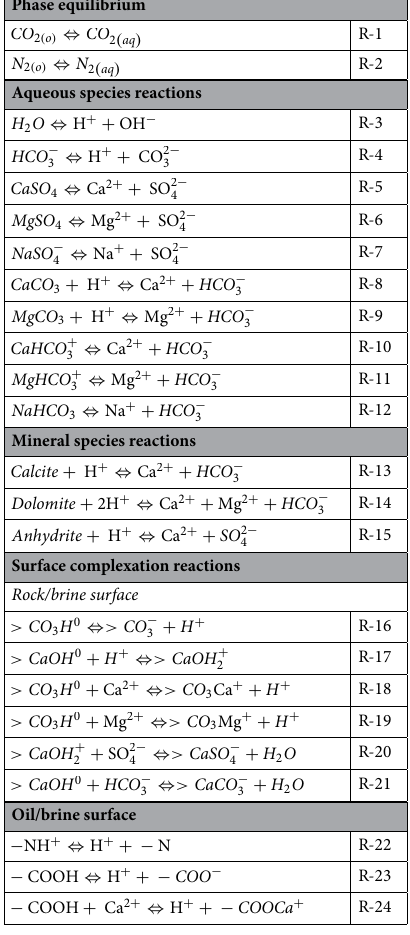
Table 1. Defined geochemical reactions (inputs to the